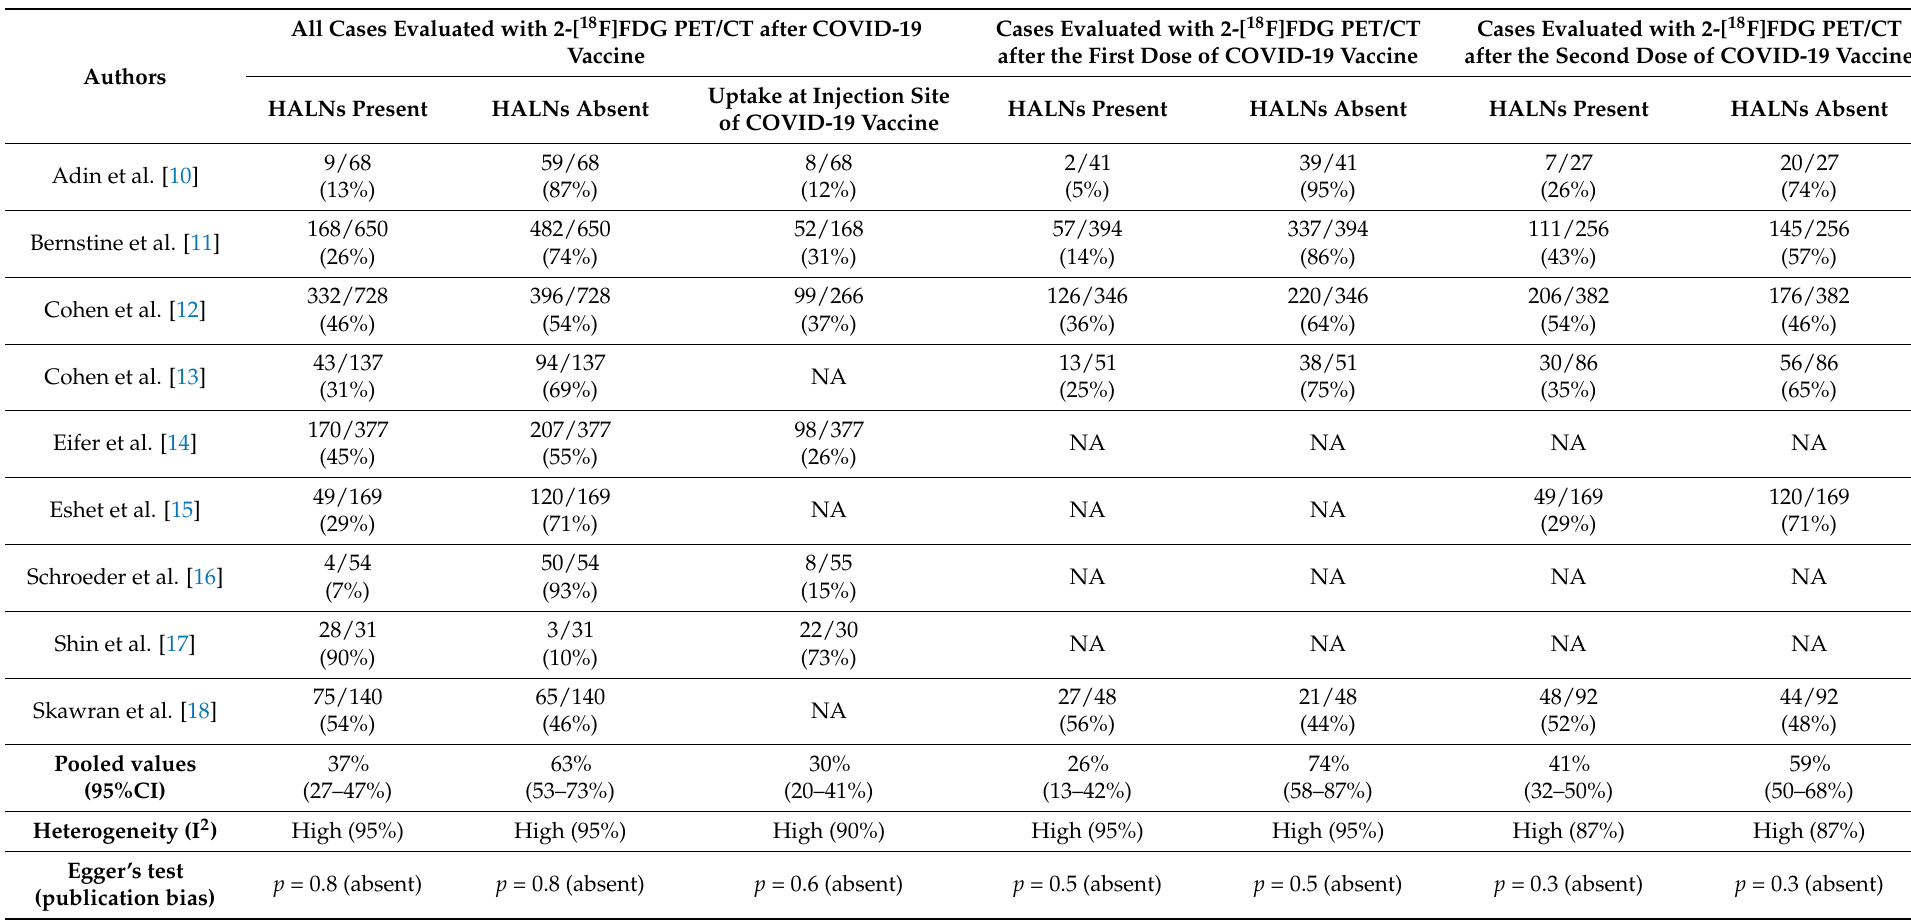
Table 3. Data on the prevalence of hypermetabolic axillary lymph nodes and deltoid muscle uptake at 2-[ 18 F]FDG PET/CT after COVID-19